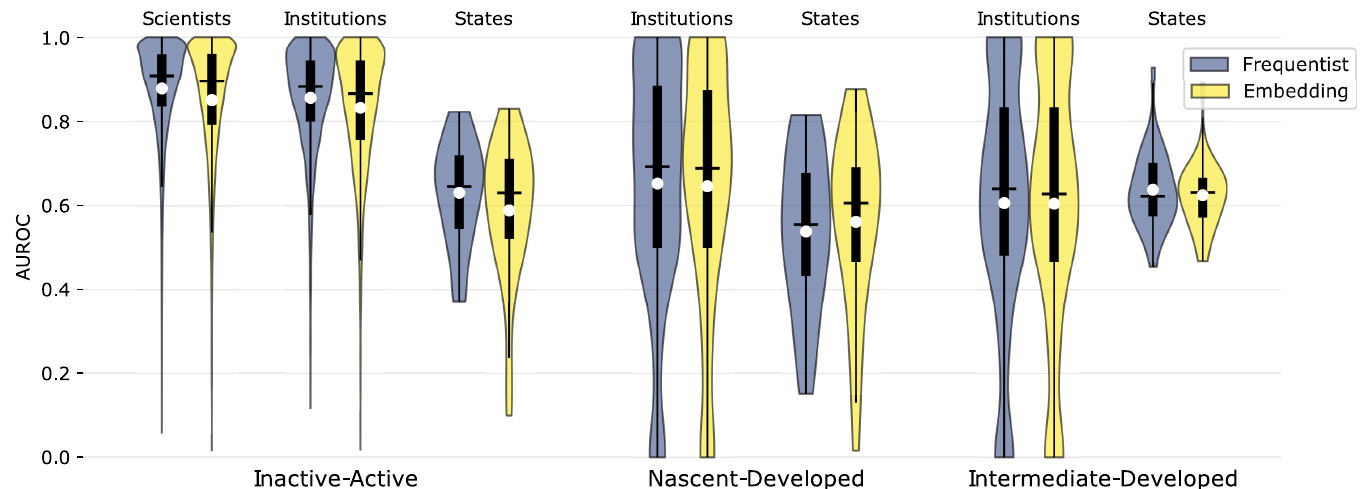
Fig 6. AUROC’s violin plots for all transitions. Violin plots of the AUROC for the predicted transitions for scientists, institutions and states. For each plot, the black horizontal line shows the median and the white circle shows the mean. Time windows are set as: model fitting, [1999, 2013], density estimation, [2011, 2013], and prediction testing, [2014, 2016].